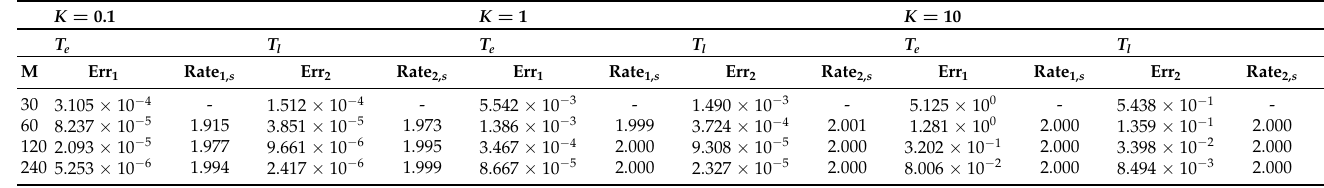
Table 6. Spatial convergence rate when N = 1000 and ( α , β ) = ( 0.5,0.5 ) for Example